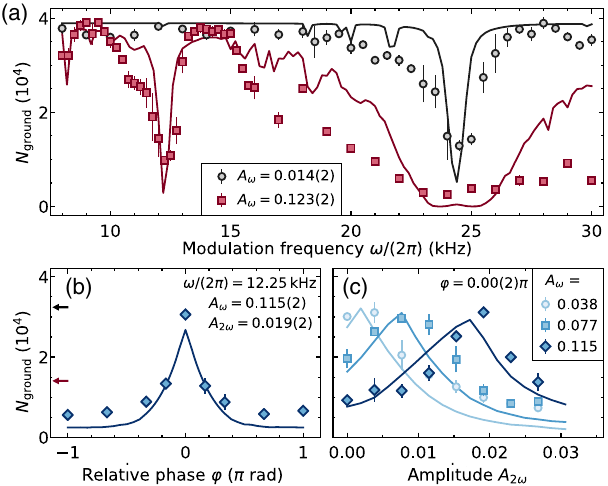
FIG. 2. Optimizing dissipation control in the noninteracting regime. (a) Single-frequency excitation spectrum for noninter- acting atoms. The data are obtained by modulating the amplitude of the lattice beam in the x direction for 20 ms for two relative strengths A ω of 0.014(2) (gray circles) and 0.123(2) (red squares). Single- and multiphoton resonance features appear at the S - P interband transition at 24.5 kHz and fractions thereof, in agree- ment with the theoretical calculation (lines) that takes into account the full lattice potential in the x - z plane (see Appendix C). (b) Ground-band population N after 20 ms of two-frequency ground modulation [Eq. (1)] as function of the relative phase φ . A matched excitation strength gives rise to a strong dependence on the relative phase in agreement with ab initio theory (lines). The black (red) arrow shows the ground-band population in the absence of any drive (in the presence of a single drive at ω ). (c) Ground-band population at φ ¼ 0 as a function of the control amplitude A 2 ω for various Floquet amplitudes A ω . As the Floquet amplitude increases, the optimum control amplitude is shifted to larger values. Error bars to measured data points are the standard error of at least three measurements (see Appendix